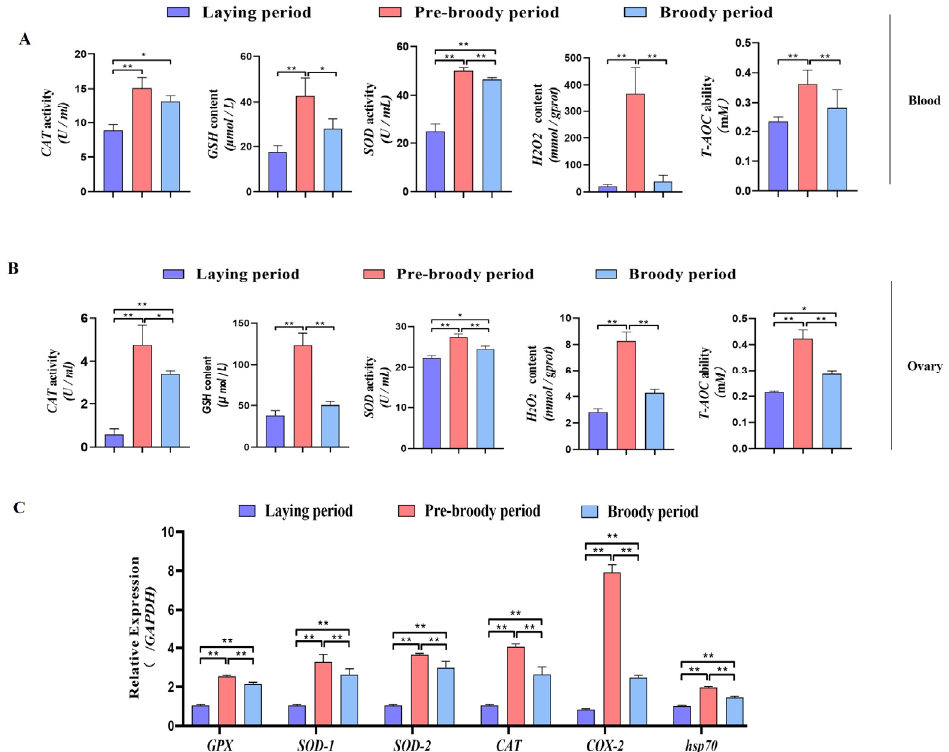
Figure 3. Analysis of oxidation indices of geese in vitro. ( A ) Changes in the CAT, GSH, SOD, H 2 O 2 and T-AOC levels in blood during different periods ( n = 8); * p < 0.05; ** p < 0.01. ( B ) Antioxidant levels in the ovaries of geese during broodiness ( n = 8). ( C ) Expression of GPX , SOD-1 , SOD-2 , COX-2 , CAT and hsp70 in the ovaries of geese during different periods ( n = 3). The values show the means ± standard errors of all experiments. Asterisks indicate significant differences (* p < 0.05, ** p < 0.01).